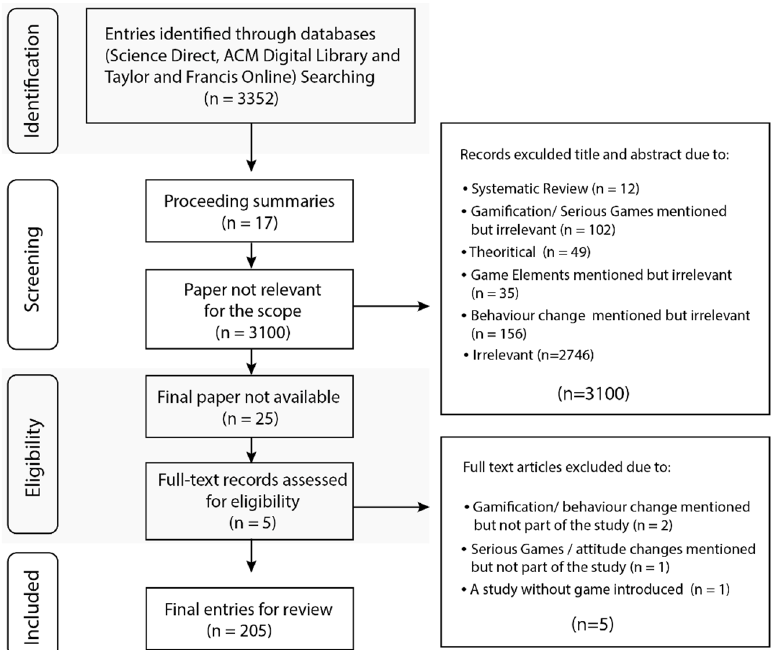
Figure 1. Flowchart of the literature review process.